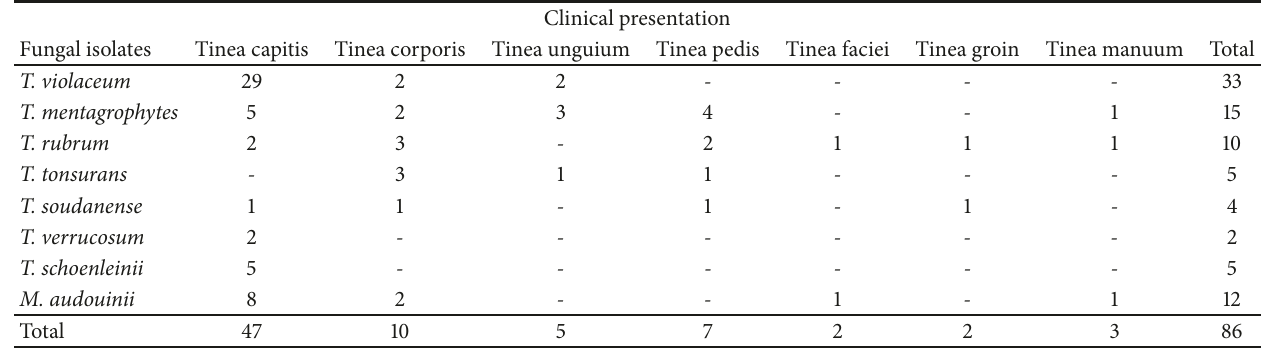
Table 4: Frequency and distribution of dermatophytes in relation to clinical manifestation. Clinical presentation